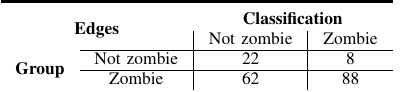
TABLE I: FACE DETECTION RESULTS